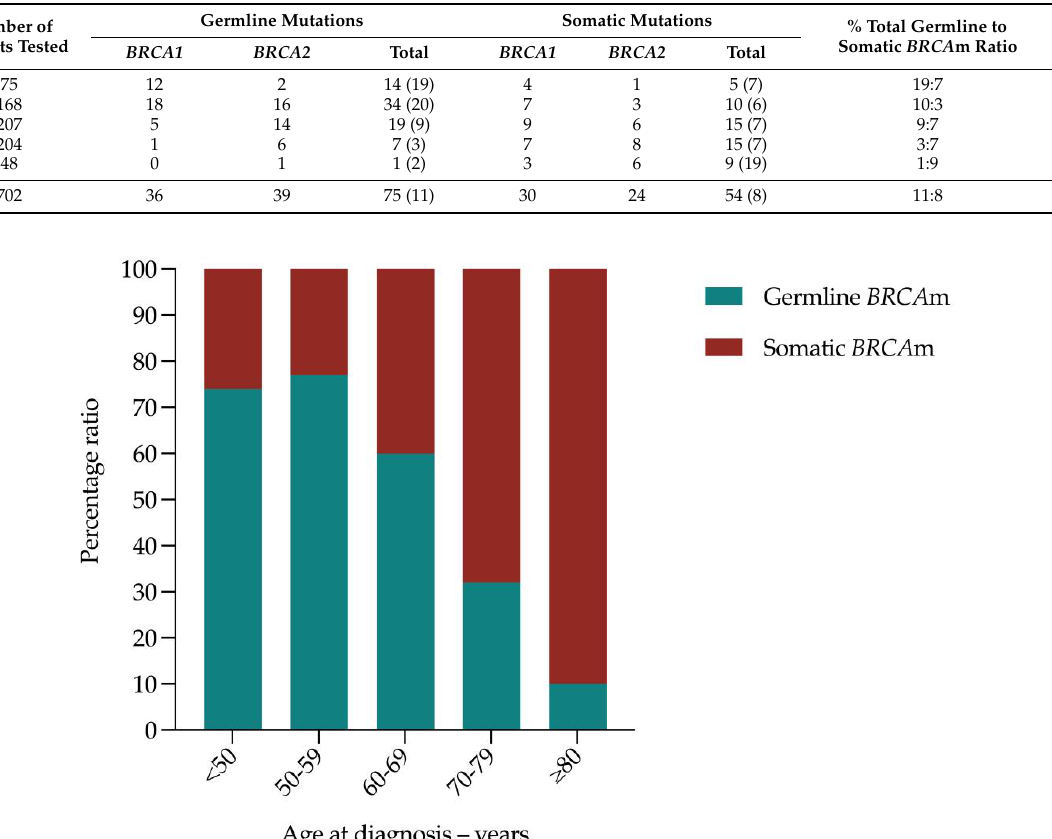
Figure 1. Percentage ratio of germline versus somatic BRCA1/2 pathogenic variants according to age group. Key: BRCA m, BRCA1/2 pathogenic variant.